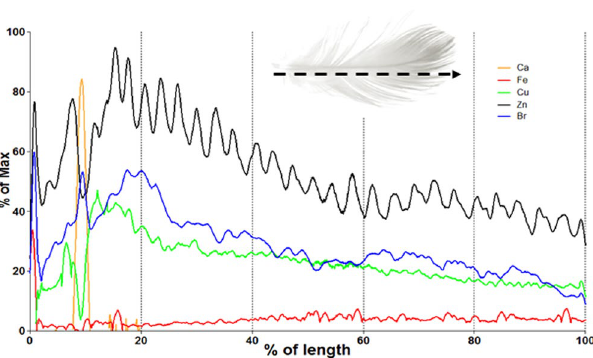
Figure 3. ( A ) A typical line profile of elemental distribution along the calamus and rachis of a shearwater breast feathers. The elements Ca, Fe, Cu, Zn and Br are found along the length of feather in discrete non-overlapping patterns, suggesting independent mechanisms of deposition. Data was plotted along the length of the rachis and calamus after normalising to the maximum